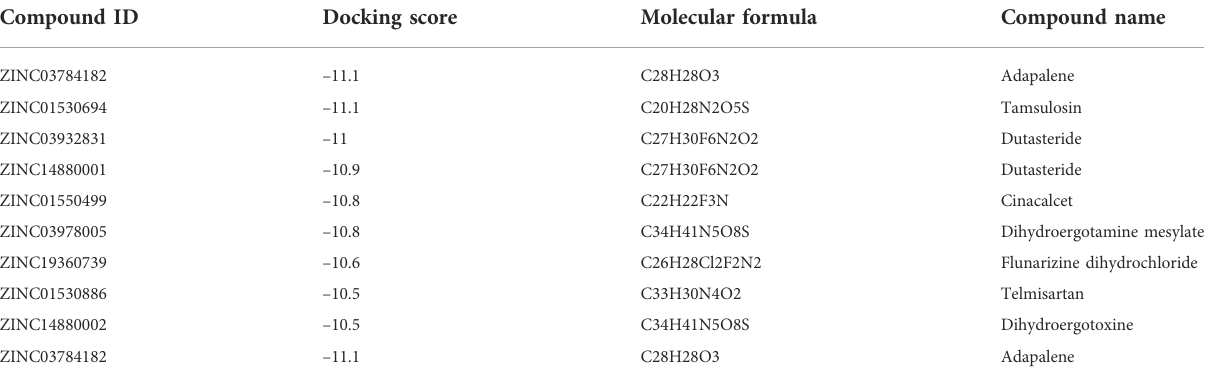
TABLE 2 Docking scores of top 10 hit FDA-approved